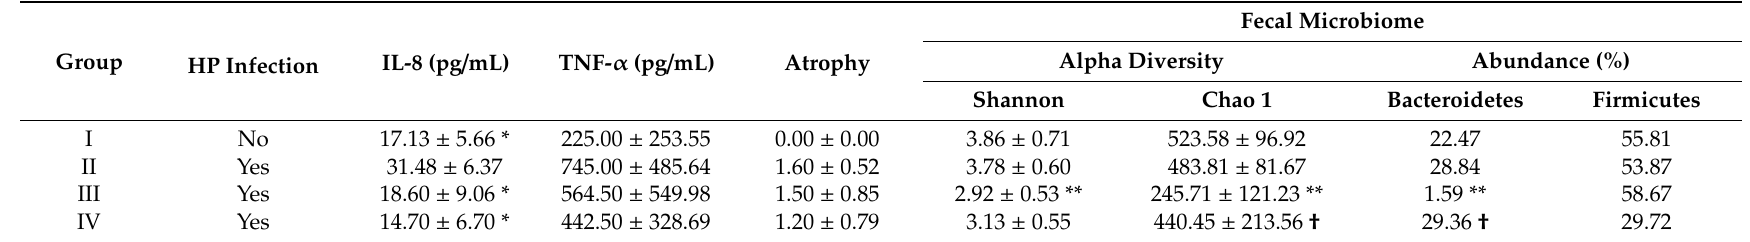
Table 2. Plasma cytokine concentrations of IL-8 and TNF- α in each